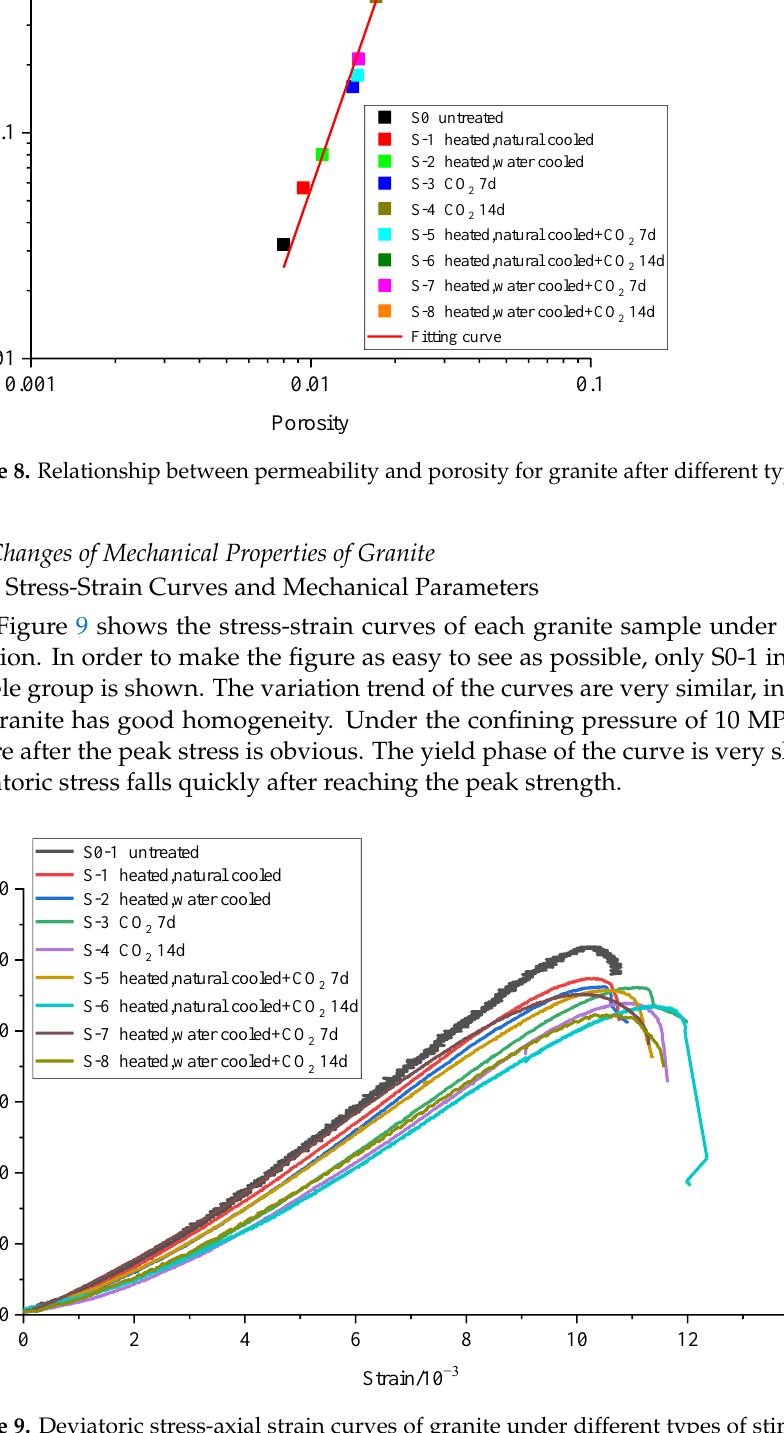
Figure 9. Deviatoric stress-axial strain curves of granite under different types of stimulation treat- ments.